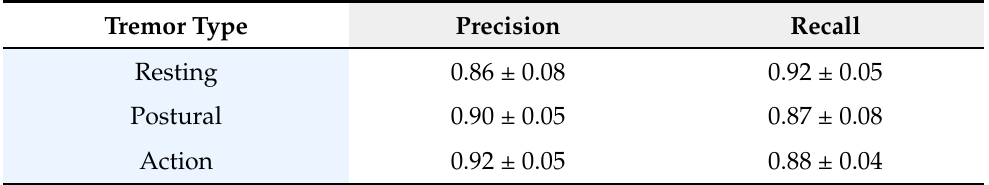
Table 6. The average precision and recall of all participants, for the tremor classification model.